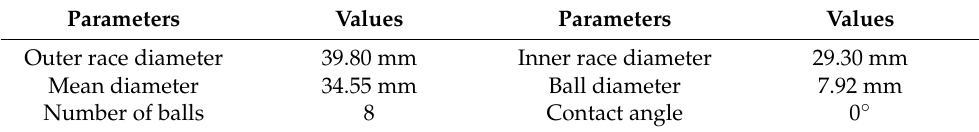
Figure 2. Bearing fault experimental setup. Table 1. The tested bearing’s parameters.